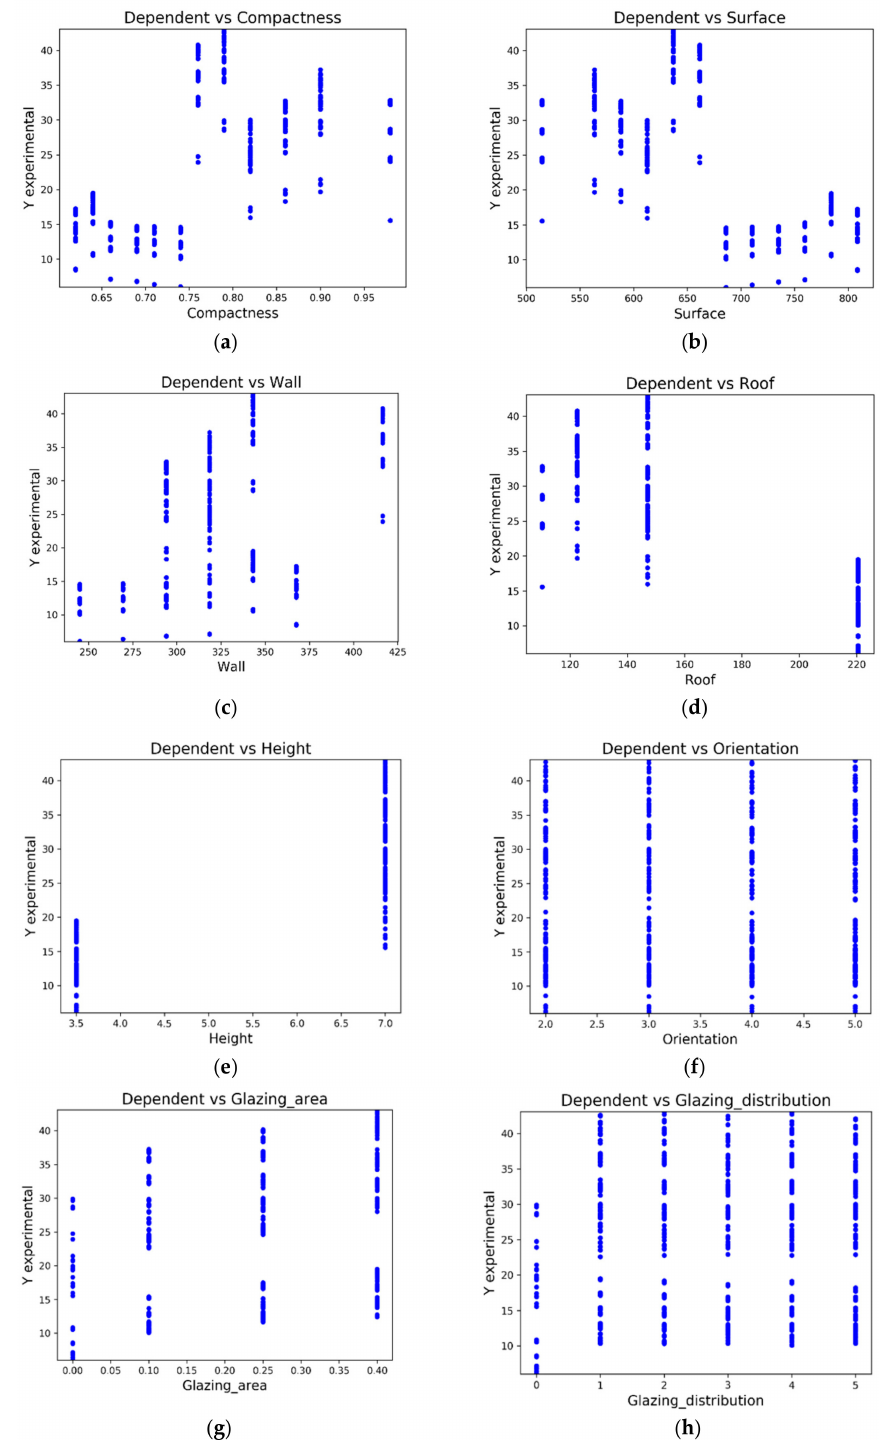
Figure 2. Heating load values depending on ( a ) relative compactness; ( b ) surface area; ( c ) wall area; ( d ) roof area; ( e ) overall height; ( f ) orientation; ( g ) glazing area; ( h ) glazing area